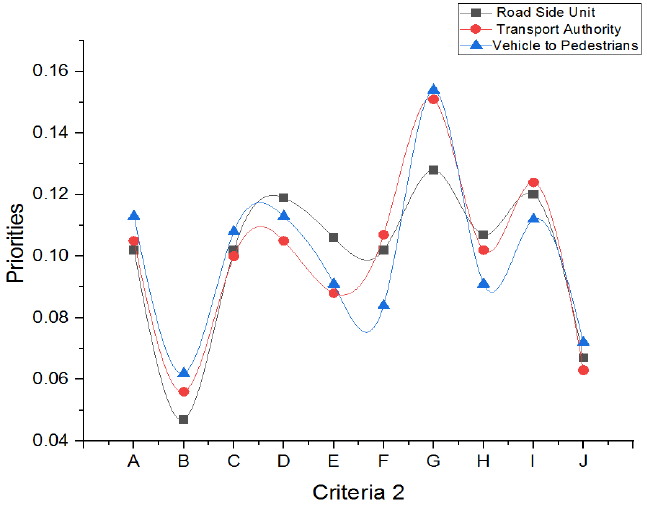
Figure 9. Criteria 2 Influence on Alternatives.